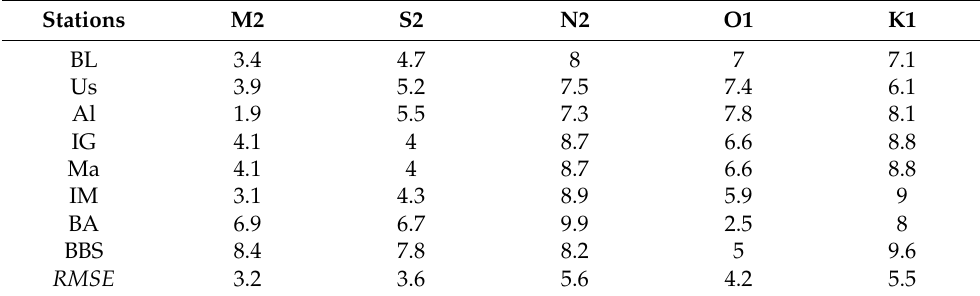
Table 1. Accuracy of the simulation results in reproducing the tidal elevation. Vectorial differences between simulated and observed values (Equation (2) for each tidal component and station and RMS (Equation (3)) obtained for each component. Results are expressed in